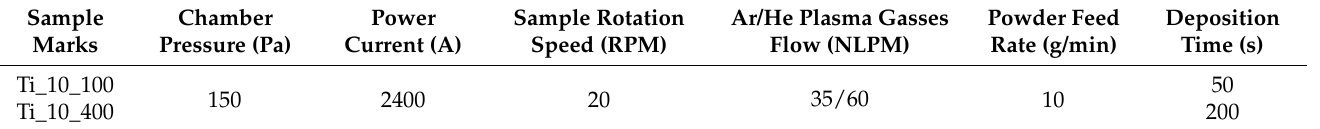
Table 2. Deposition parameters of YSZ ceramic